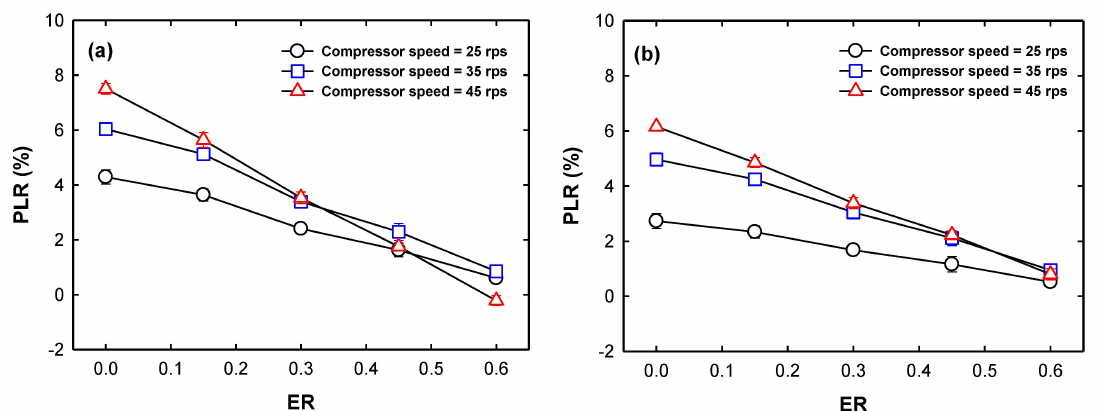
Figure 7. Variations in PLR according to ER for various compressor speeds at NXPs of ( a ) 0 and ( b ) 6 mm.